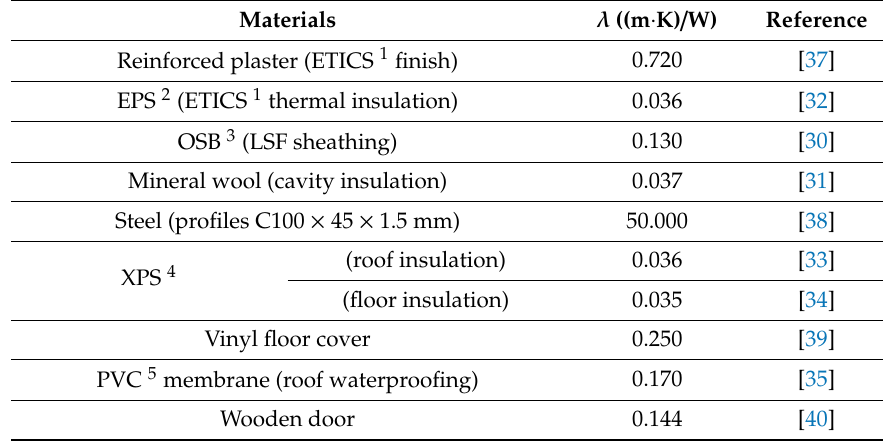
Table 1. Thermal conductivity ( λ ) of the materials used in the lightweight steel frame (LSF) modules.